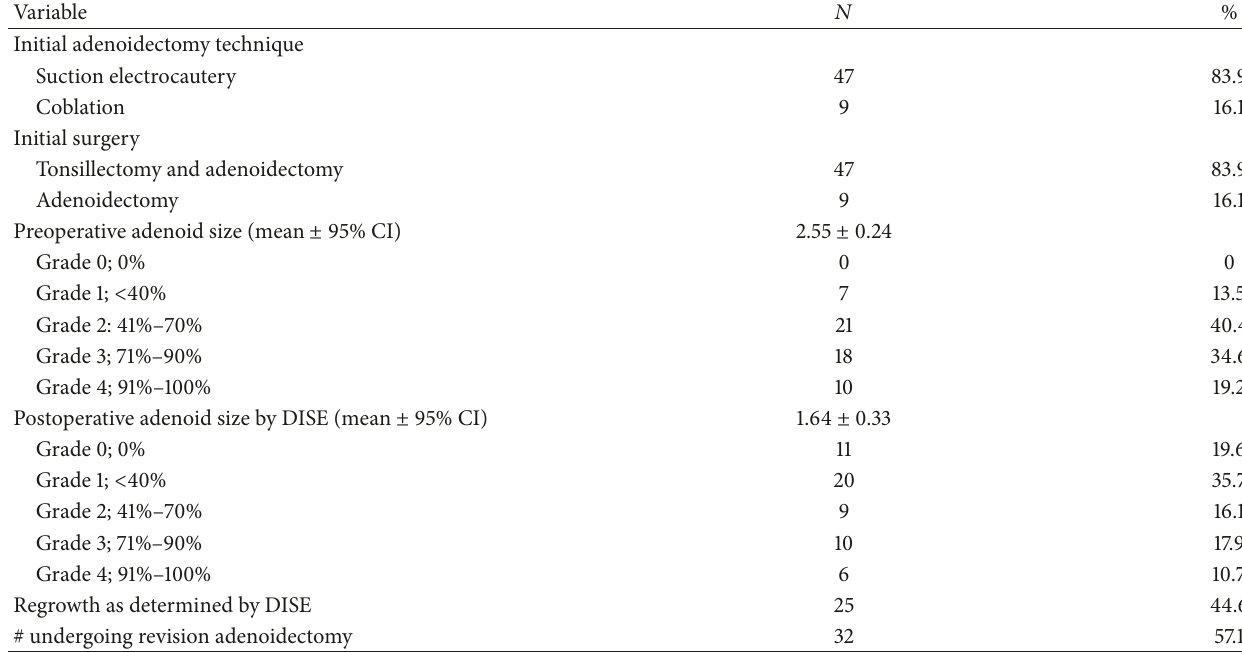
Table 2: Adenoid characteristics.